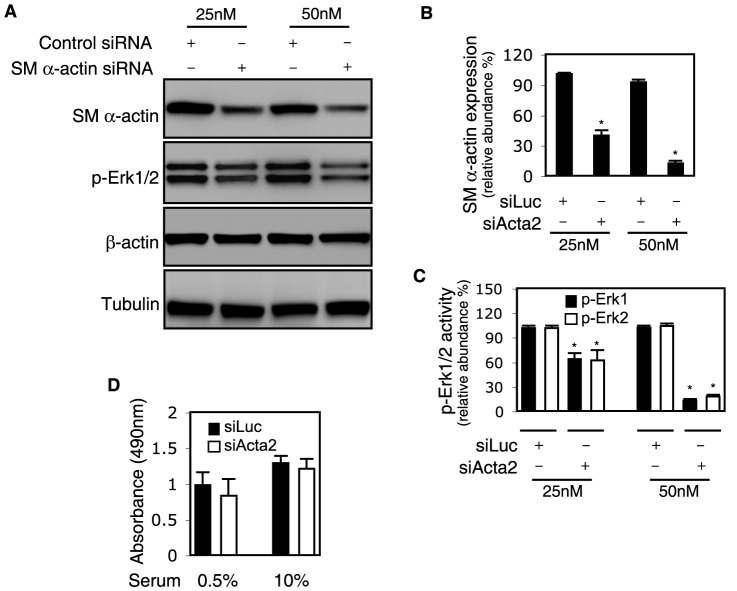

Acta2 and Erk signaling.In (A), rat stellate cells were isolated and grown in standard medium for 2 days as described in methods and then exposed to smooth muscle (SM) α actin (Acta2) siRNA (siActa2) or control siRNA (siLuc) for 48 hours as in Methods. Cells were incubated in 0.5% serum medium for a further 24 hours and then harvested. Equal quantities of protein lysate (25 µg) were subjected to immunoblotting to detect the identified proteins and representative images are shown; quantitative data are presented graphically (B and C, n = 3; *p<0.05 for siLuc vs. siActa2). In (D), stellate cells as above were seeded at a density of 1×104 per well in 96 well plates and transduced siRNA siActa2 or control siRNA siLuc for 48 hours and then incubated in 0.5% or 10% serum medium for a further 24 hours. Cell proliferation was measured as described in Methods, with proliferation being proportional to absorbance. Abbreviations: SM - smooth muscle; siActa2 - smooth muscle α actin or Acta2 siRNA; siLuc - luciferase siRNA.